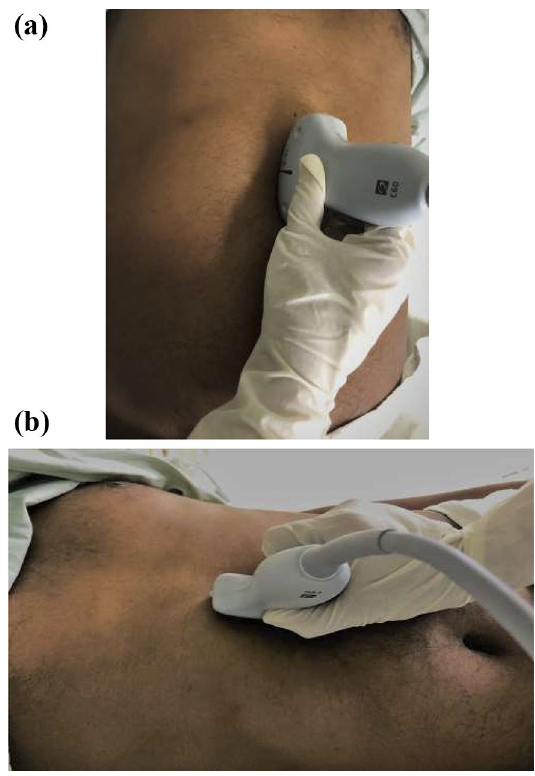
Fig. 1 a Scanning in supine position. b Scanning in right lateral decubitus